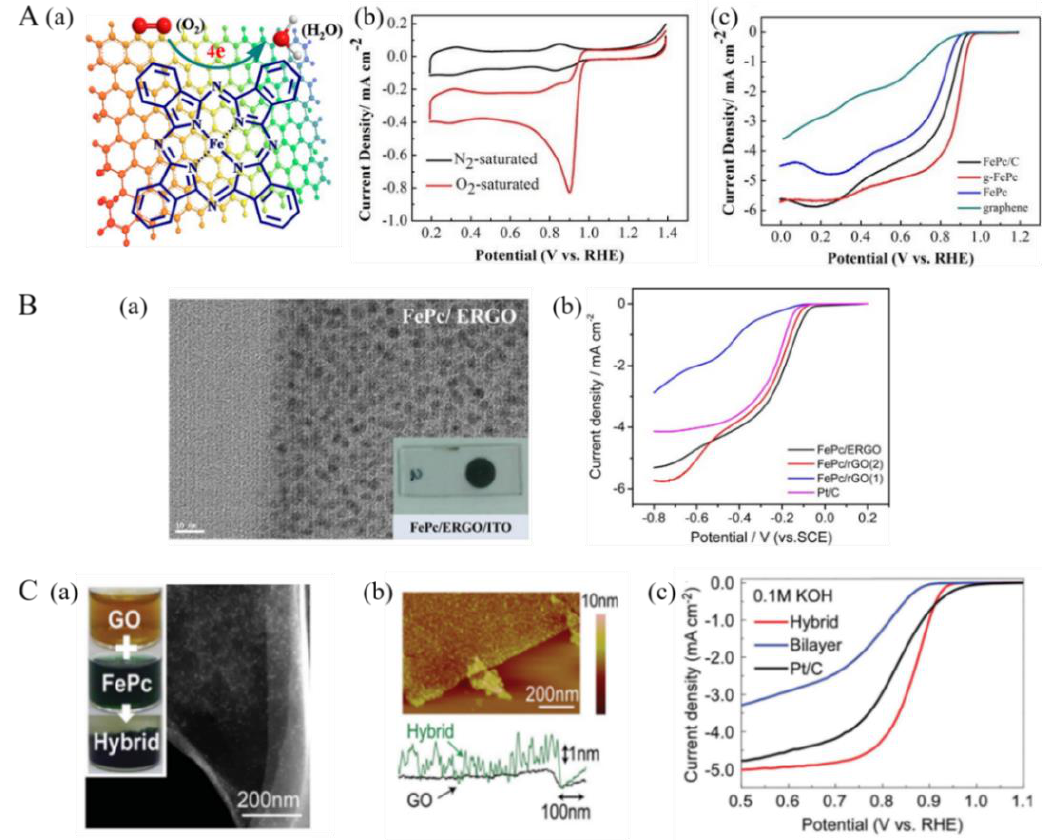
Figure 2. ( A ) ( a ) Schematic of the interaction between FePc and graphene, ( b ) CV curves of g-FePc in N 2 - and O 2 -saturated 0.1 M KOH electrolyte at a scan rate of 10 mV / s, and ( c ) linear sweep voltammetry (LSV) curves of FePc / C, g-FePc, FePc, and graphene in O 2 -saturated 0.1 M KOH electrolyte at 1600 rpm adapted from ref [41] Copyright 2013 American Chemical Society. ( B ) ( a ) TEM image of FcPc / ERGO. The inset shows a photograph of the FcPc / ERGO film on the indium-tin-oxide glass. ( b ) LSV curves of FcPc / ERGO, FcPc / rGO(1), FcPc / rGO(2), and Pt / C, adapted from ref [45] Copyright 2015 American Chemical Society. ( C ) ( a ) HAADA-STEM image of FePc / Go hydride with photographs of GO solution, FePc solution, and the precipitated FePc / Go hydride, and ( b ) LSV curve of FePc / Go hydride, FePc / Go bilayer, and Pt / C in 0.1 M KOH electrolyte at 1600 rpm, adapted from ref [46] Copyright 2013